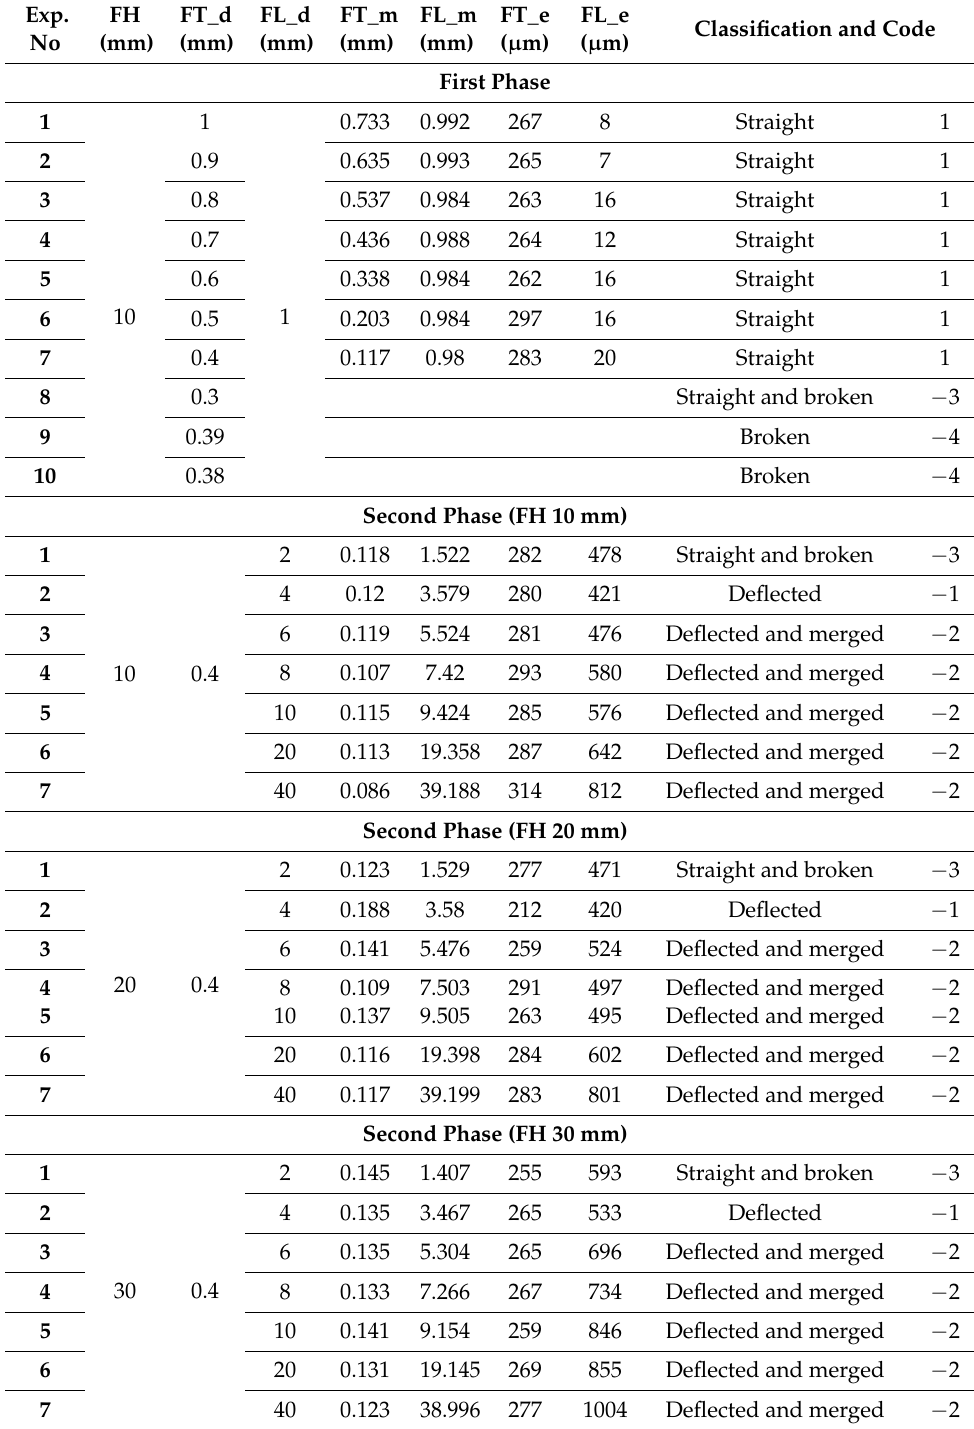
Table 4. Experimental results of thin structures produced in D2